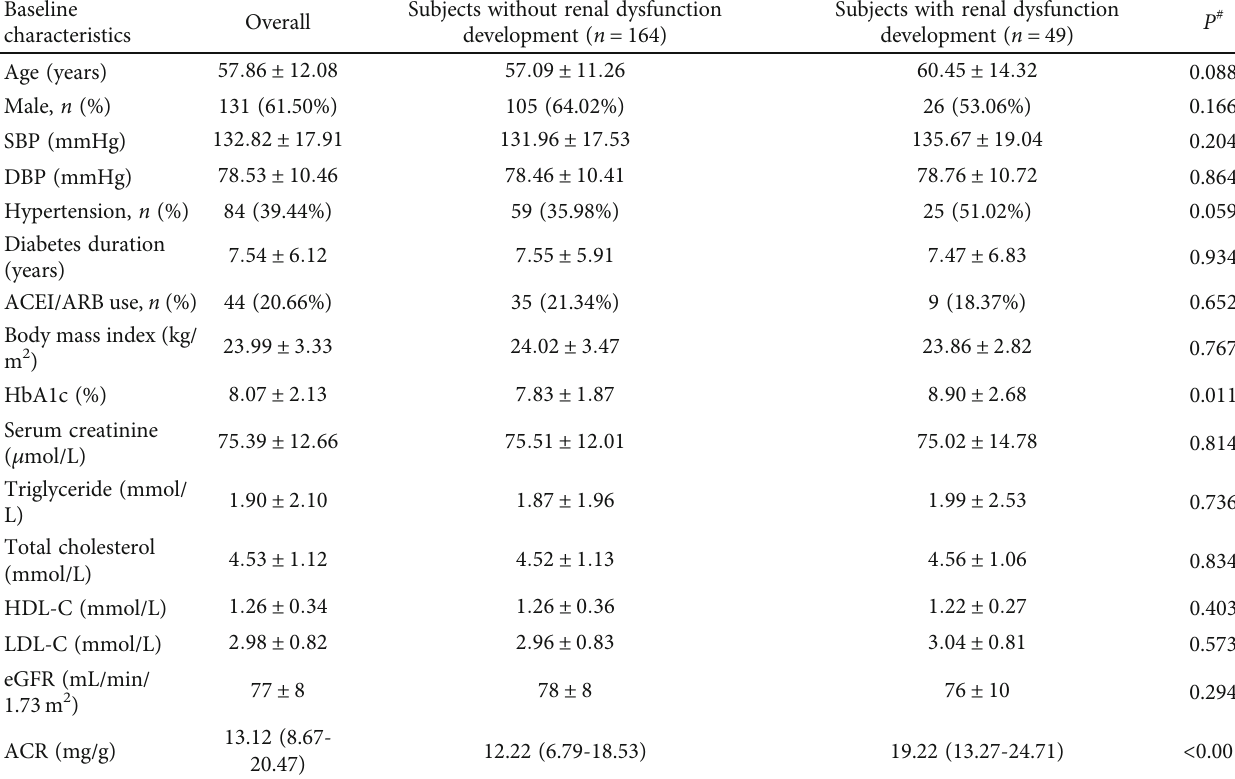
# The comparison of the baseline characteristics between subjects with and without renal dysfunction development. SBP: systolic blood pressure; DBP: diastolic blood pressure; ACEI: angiotensin-converting enzyme inhibitor; ARB: angiotensin receptor blocker; HbA1c: glycated hemoglobin; HDL-C: